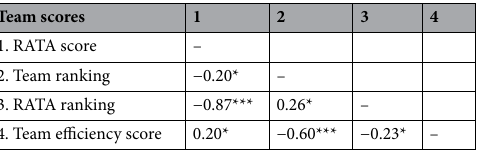
Table 6. RATA score and team efficiency and success relation (n = 53). *p < 0.05, **p < 0.01, ***p <